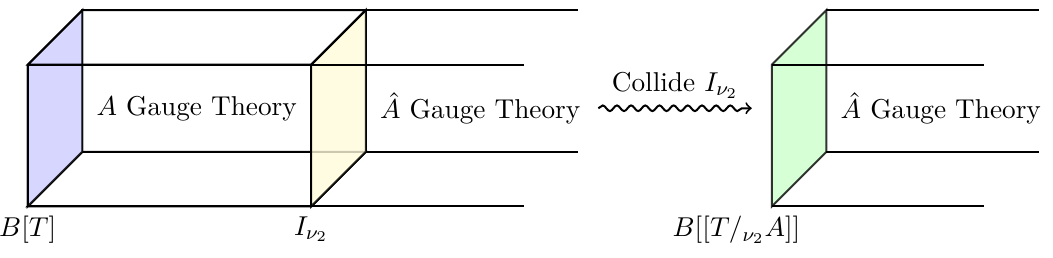
Figure 3 . In the folding trick, we replace the setup with a gauge theory B on the left of the interface and gauge theory A on the right of the interface, by a product theory A × ¯ B with a corresponding boundary condition.